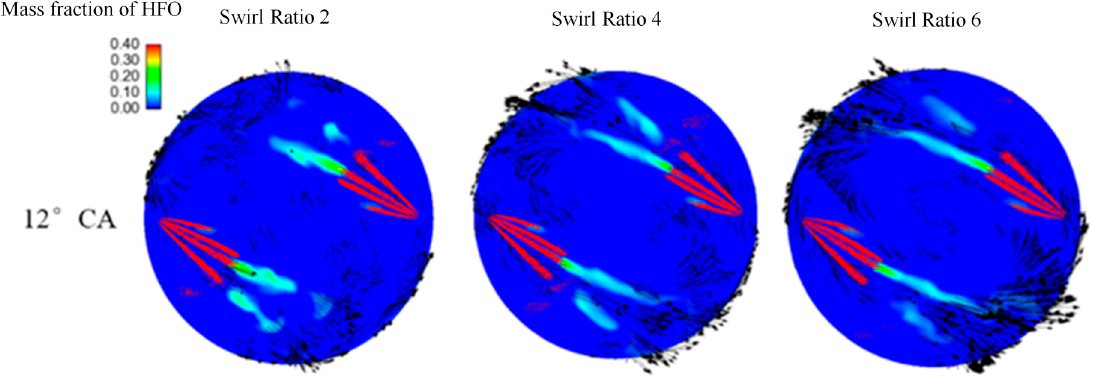
Figure 14. Distributions of gas and liquid phases of spray and flow field.